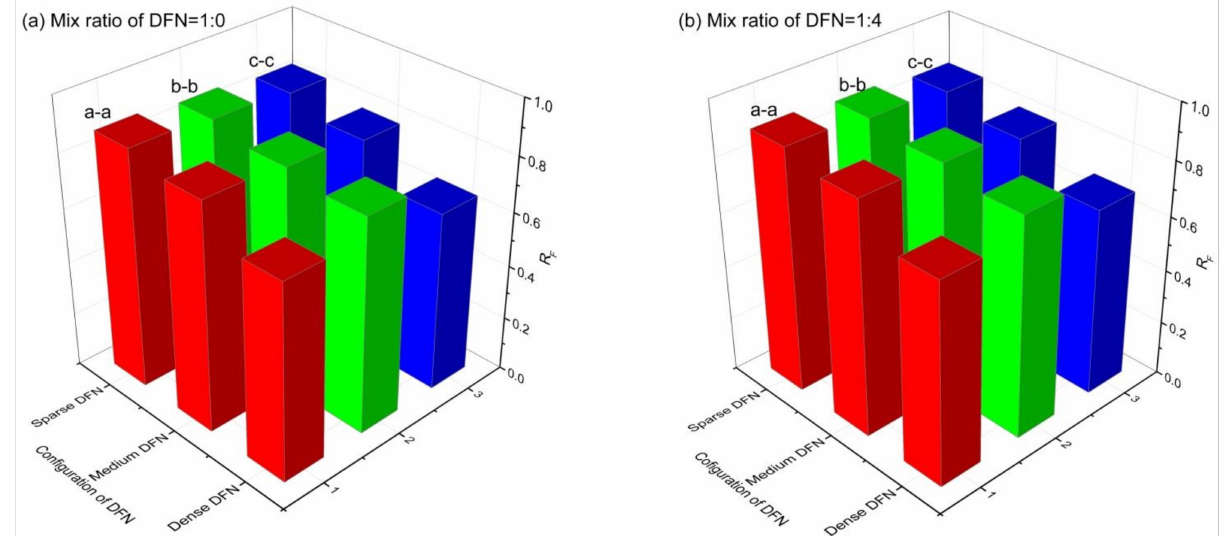
Figure 13. The plot of the index R F against natural fracture density. The terms “a-a”, “b-b”, and “c-c” indicate that three profile were selected to measure the velocity. ( a ) Model blocks with 1:0 mixed cement paste interface; ( b ) Model blocks with 1:4 mixed cement paste